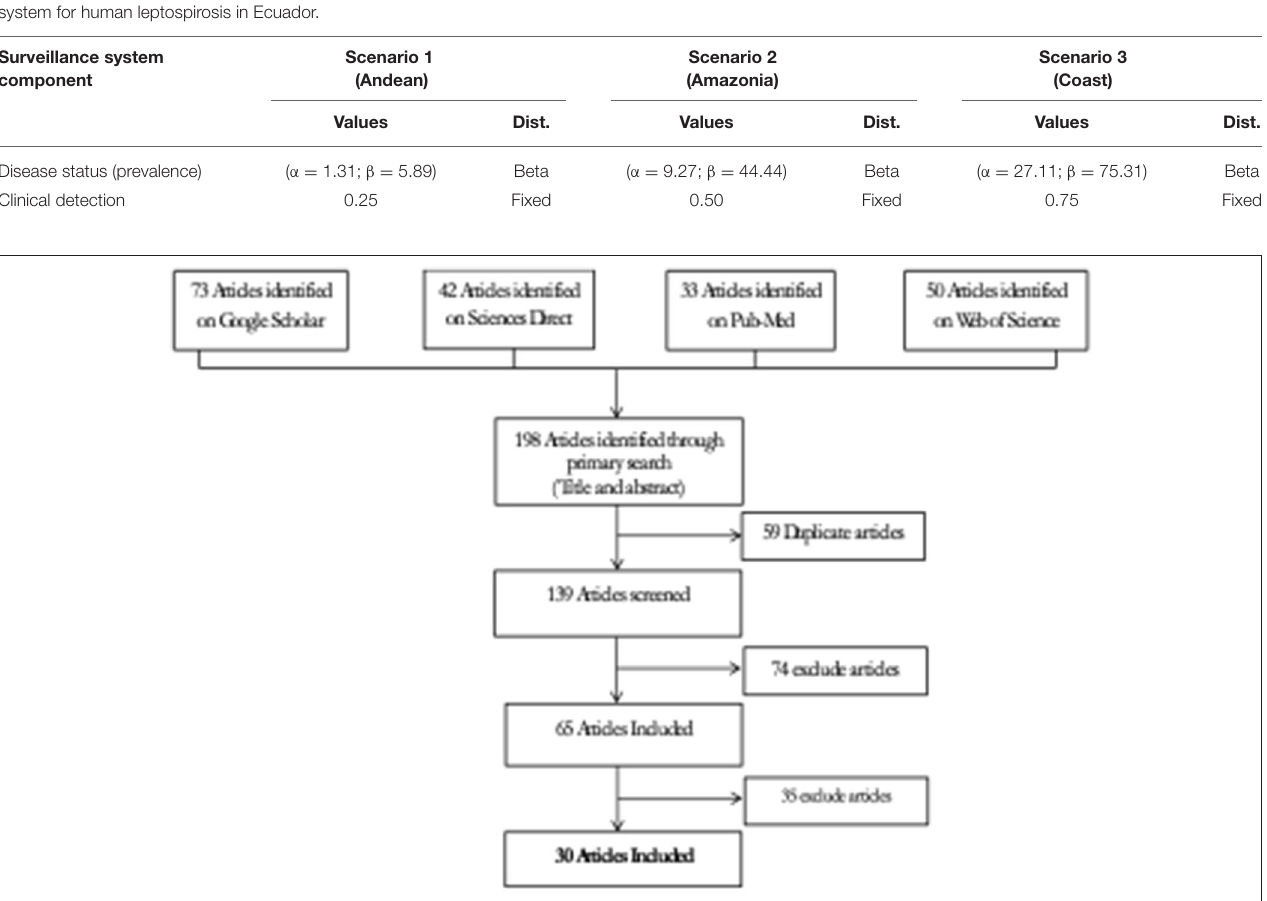
FIGURE 2 | Flow chart diagram of studies selection process in the metaanalysis.